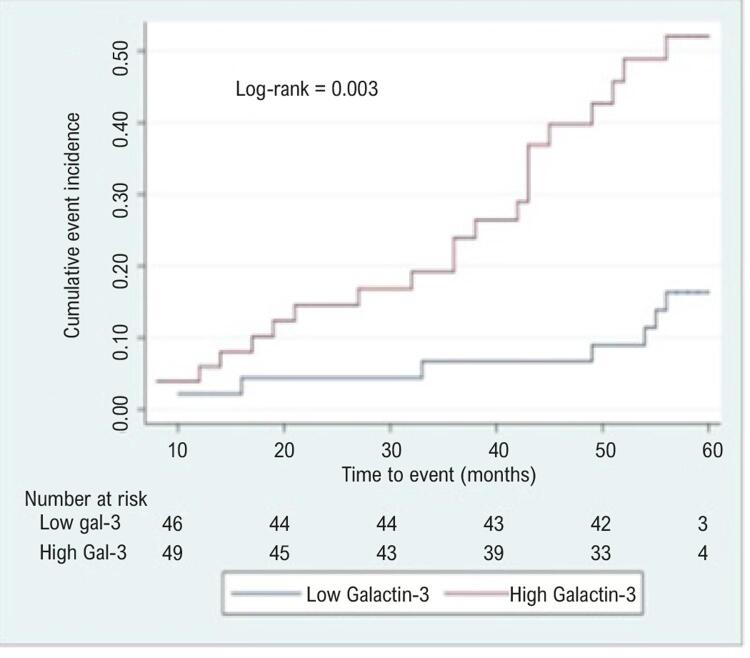
– Time-to-event curves between Gal-3 levels. Time-to-event curves between stratified Gal-3 levels results in CC-Dys. Cutoff level: Gal-3 <15.3 ng/mL.